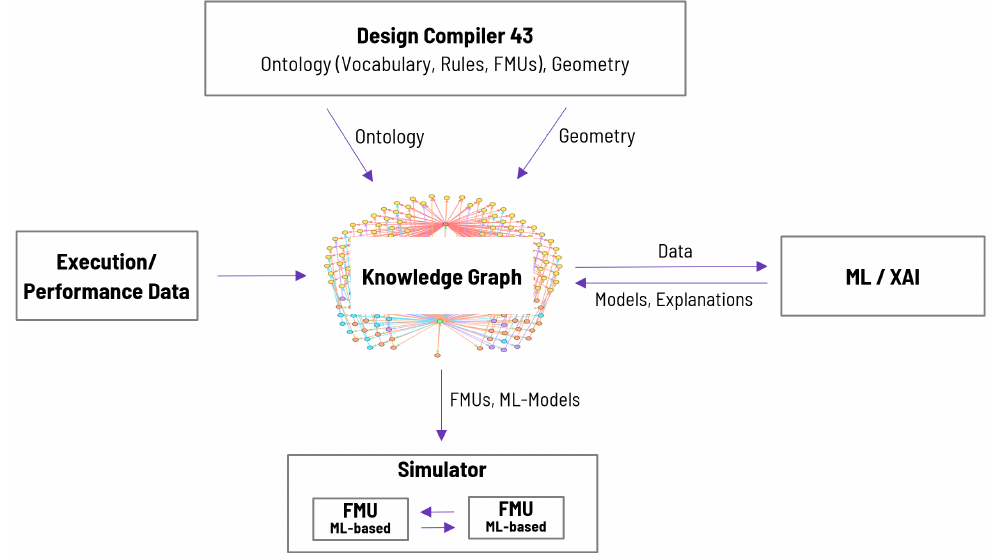
Figure 10. Digital twin